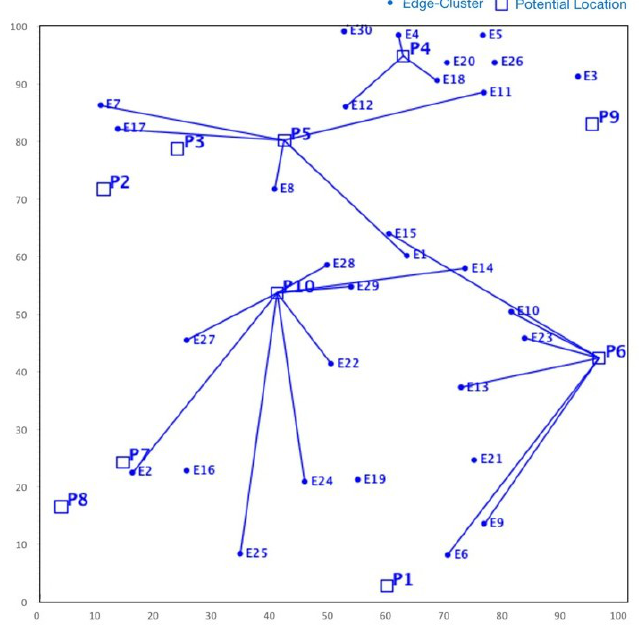
Figure 12. Output layout for NSGA-II at e avg v = 77.31 units, 322.4